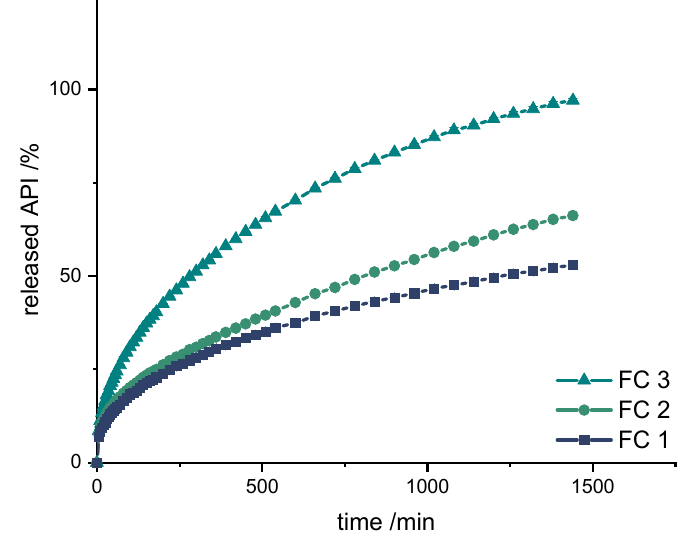
Figure 5. Dissolution of LD/BZ from FC1, FC2, and FC3; modified basket apparatus, 1000 mL 0.1 N HCl, 50 rpm, 37.0 ± 0.5 °C. x ± s; n = 3.